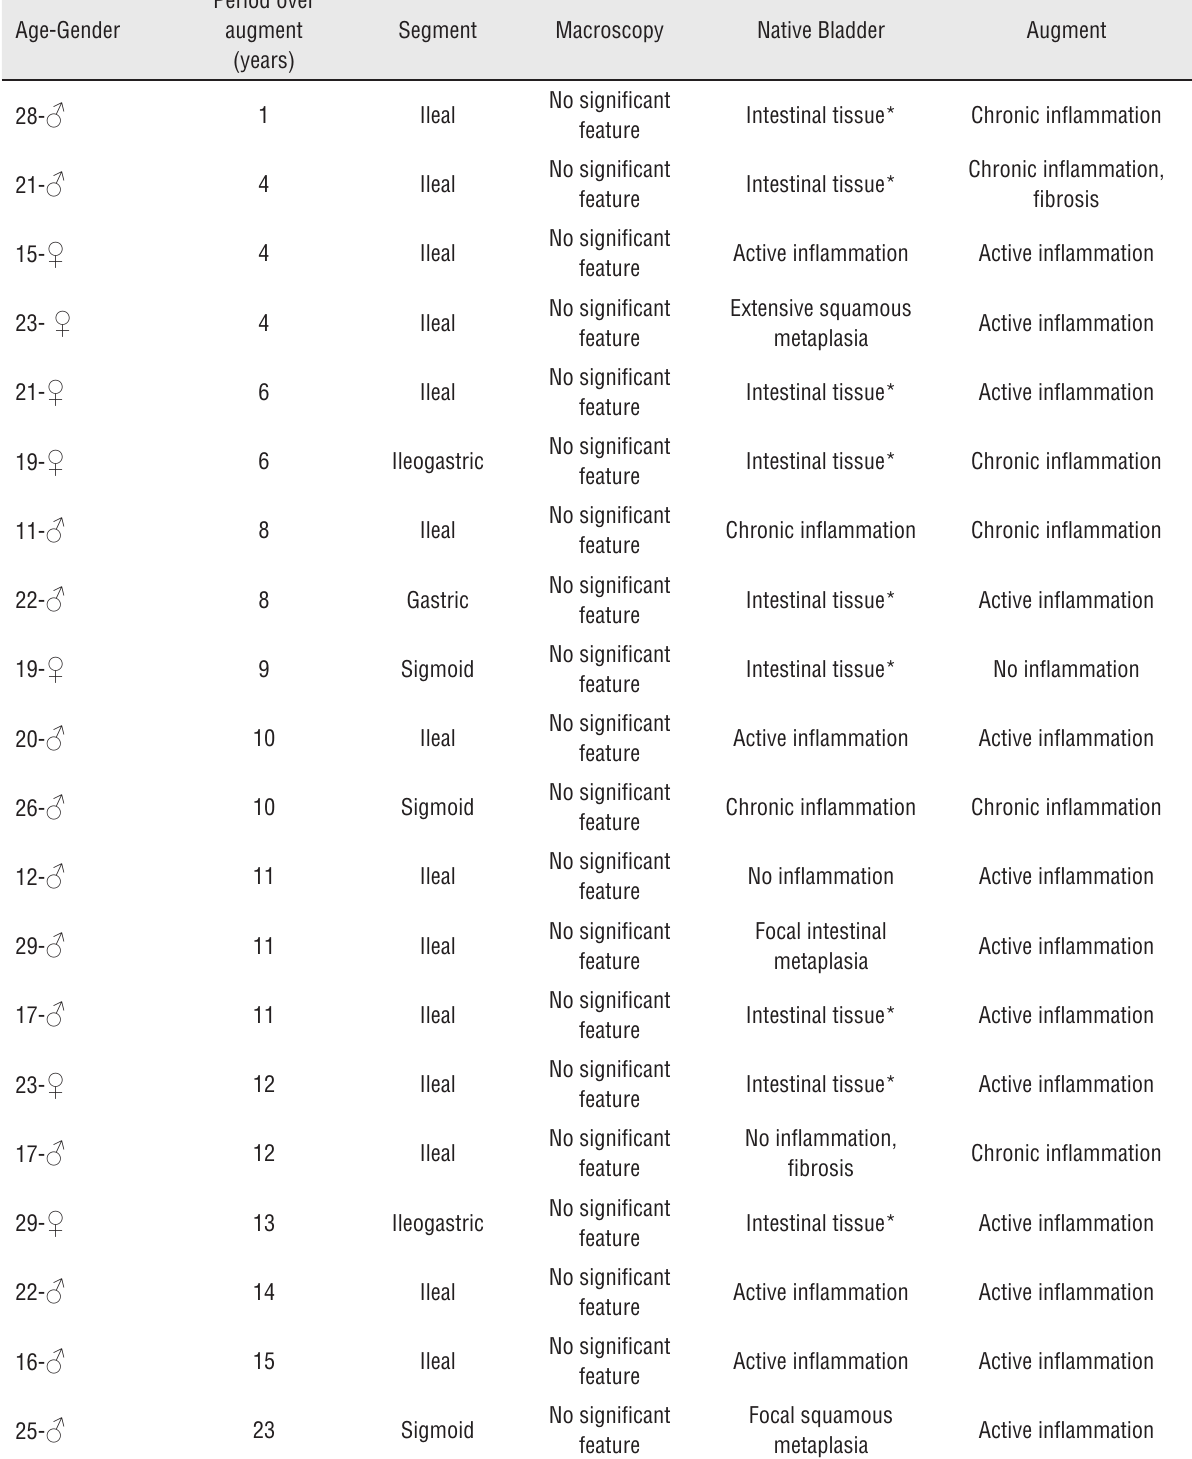
Table-1 - histopathologic findings (Table separated according to years passed over augmentation). “*”: biopsies with presumed native bladder tissue coming out as intestinal tissue (possible